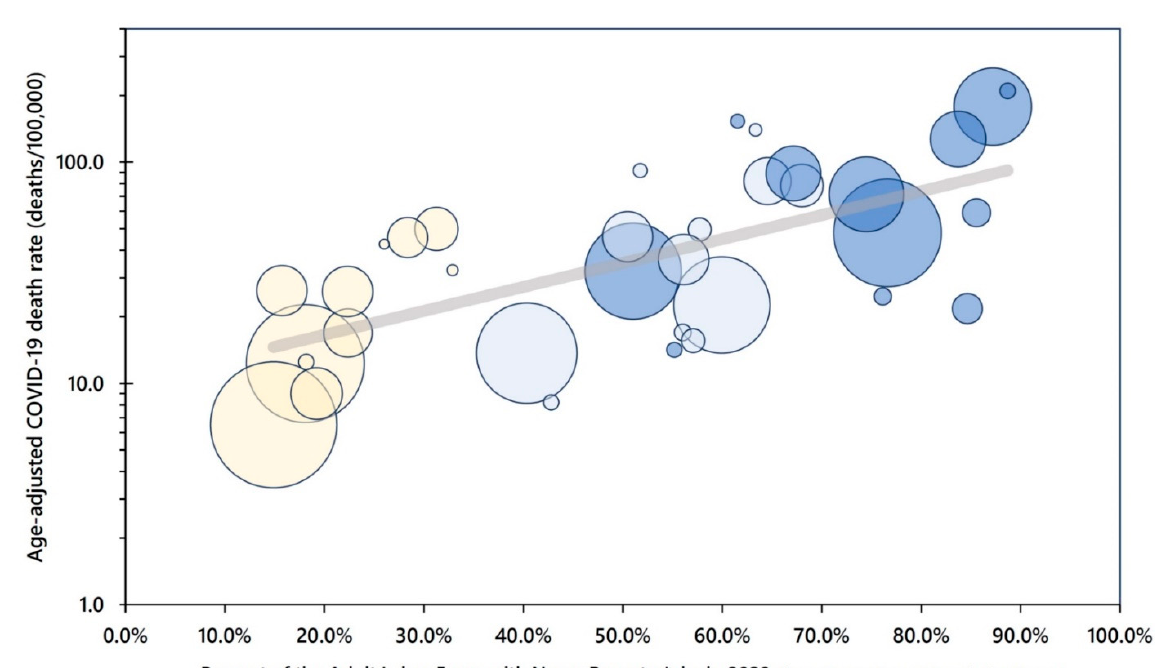
Figure 5. COVID-19 Mortality by Never Remote (Blue Collar/Service/Retail) Jobs among Adults 25 to 64 Years Old, United States 2020. Note : Each bubble represents a socioeconomic position (SEP) ‐ gender ‐ racial/ethnic group, with bubble size proportional to population size. Dark blue = low SEP, light blue = intermediate SEP, and yellow = high SEP.